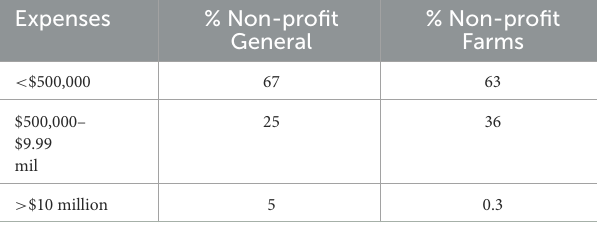
TABLE 1 Budgets (expenses): Percent general non-profits vs. non-profit farms.